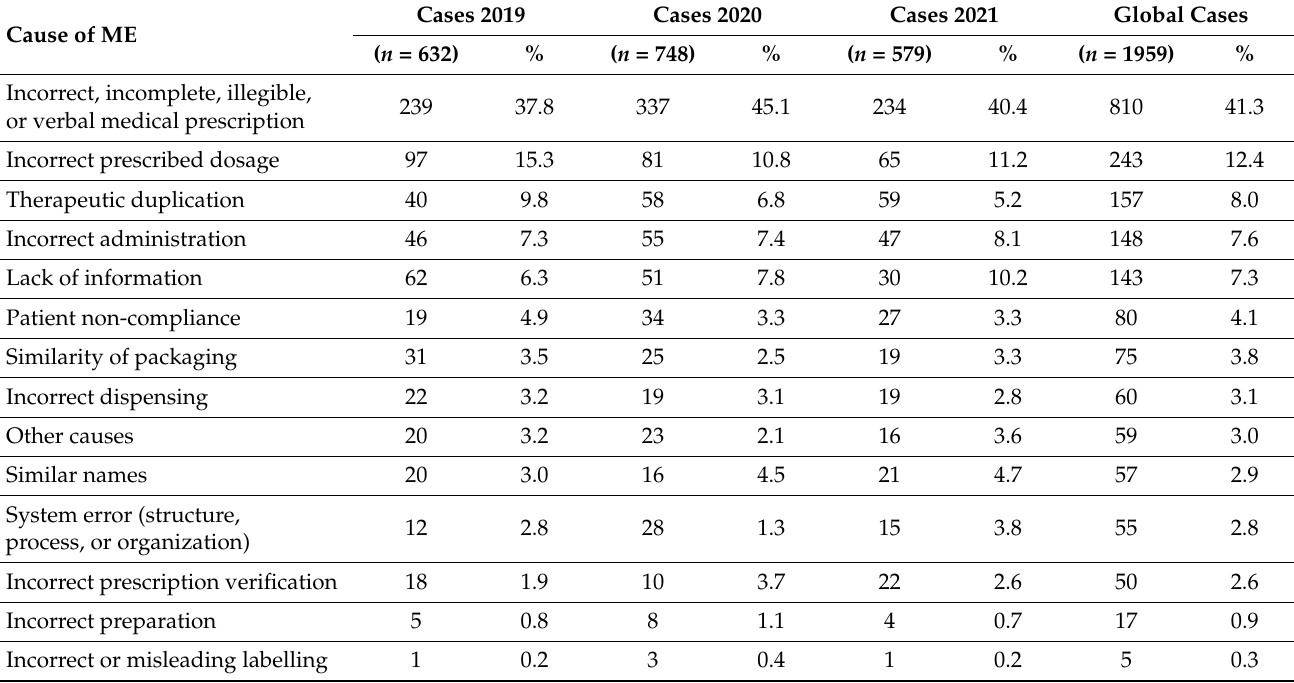
Table 1. Numbers and percentages of ME cases based on the causes and processes of the therapeutic chain involved in the ME (Catalonia, 2019 – 2021).